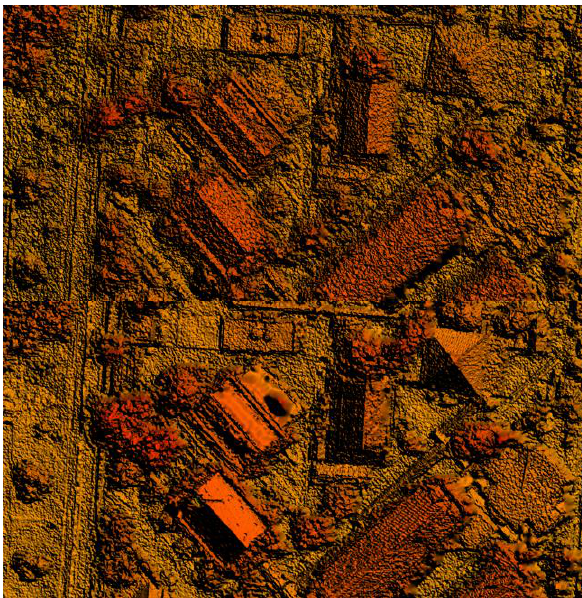
Figure 9. DSM in 10 cm GSD of BIG’s office: UAV Canon S- 100 (upper) and Airborne RCD30